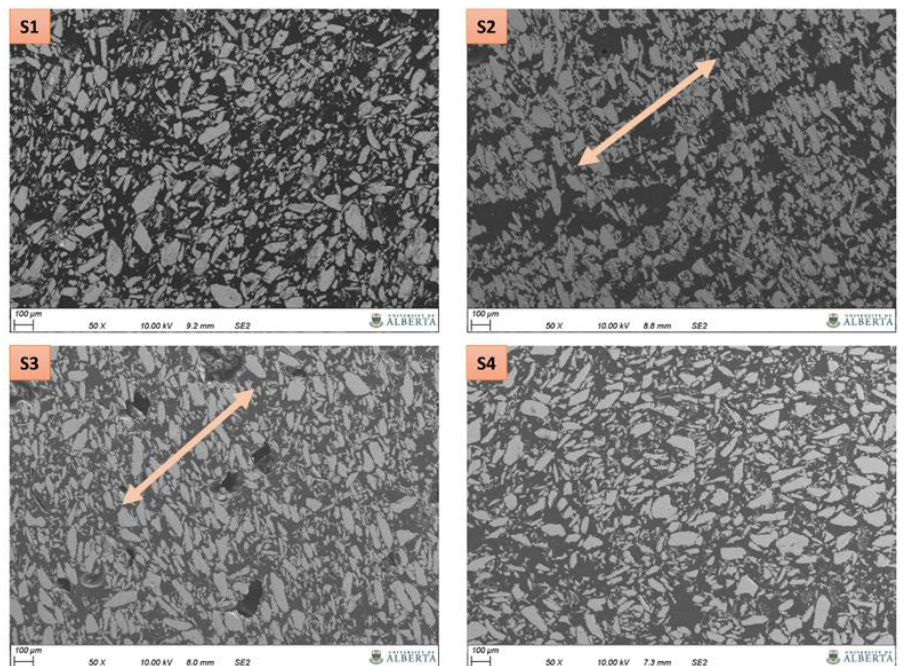
Figure 9. SEM micrographs of magnetic composites as listed in Table 1. Arrows indicate apparent particle stacking and